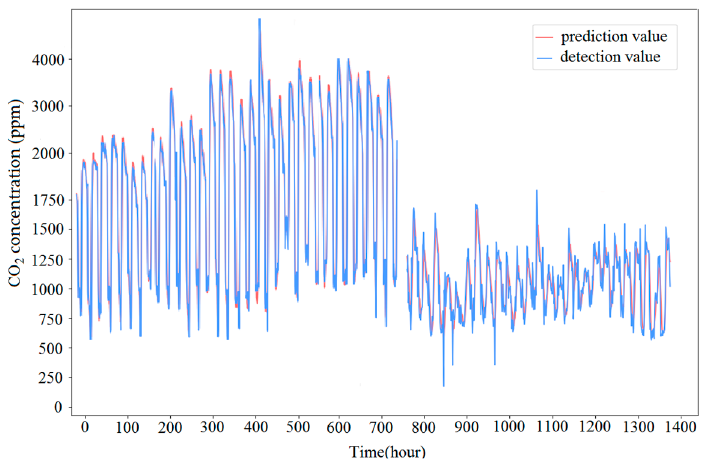
Figure 8. Prediction results of EEMD–GRU model. Note: The data on the left are autumn and winter, the data on the right are spring and summer.